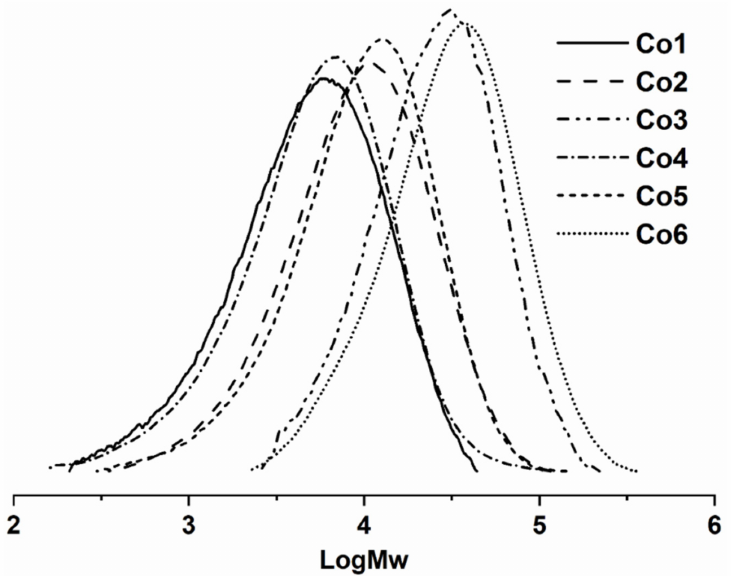
Figure 10. GPC curves showing log M w of the polyethylenes produced using Co1 – Co6 with MMAO as activator in each case (runs 7–12, Table